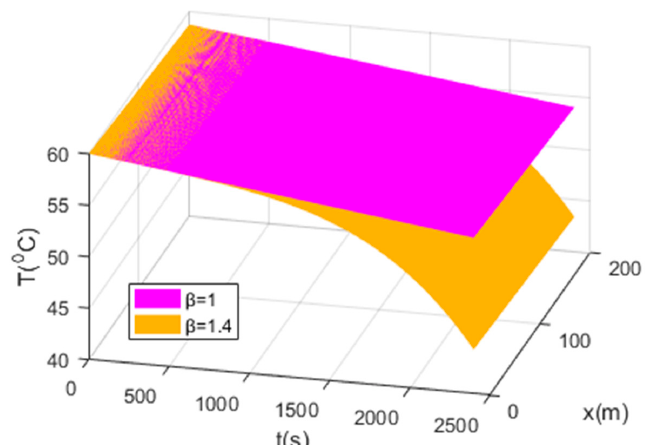
Figure 6. Dynamic 3D map of pipeline temperature.